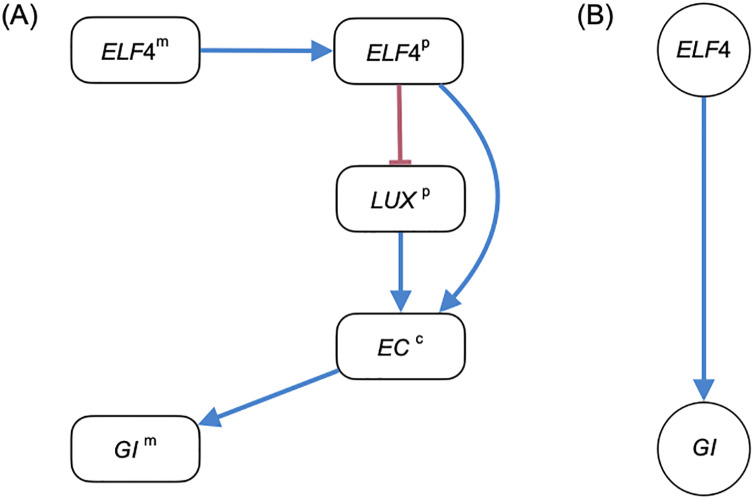
Molecular graph and gene regulatory graph of the ELF4–GI regulation in the study [23].(A) The molecular graph with blue edges indicating positive partial derivatives and red edges indicating negative partial derivatives. (B) The gene regulatory graph.